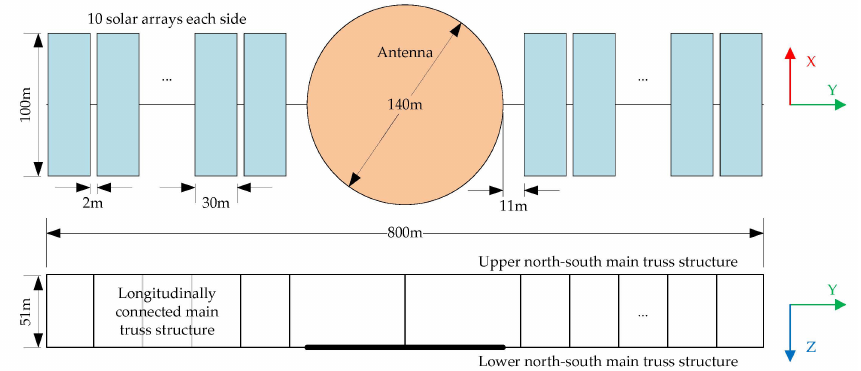
Figure 1. Structure of the MW-level